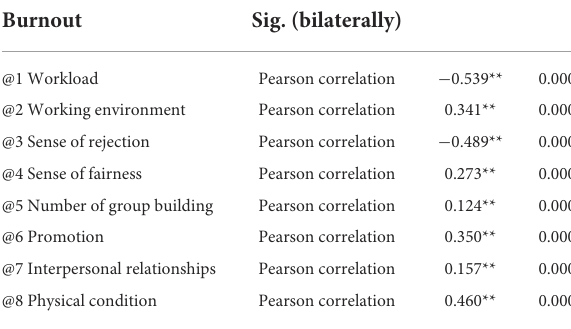
TABLE 6 Correlation analysis of influencing factors and burnout.